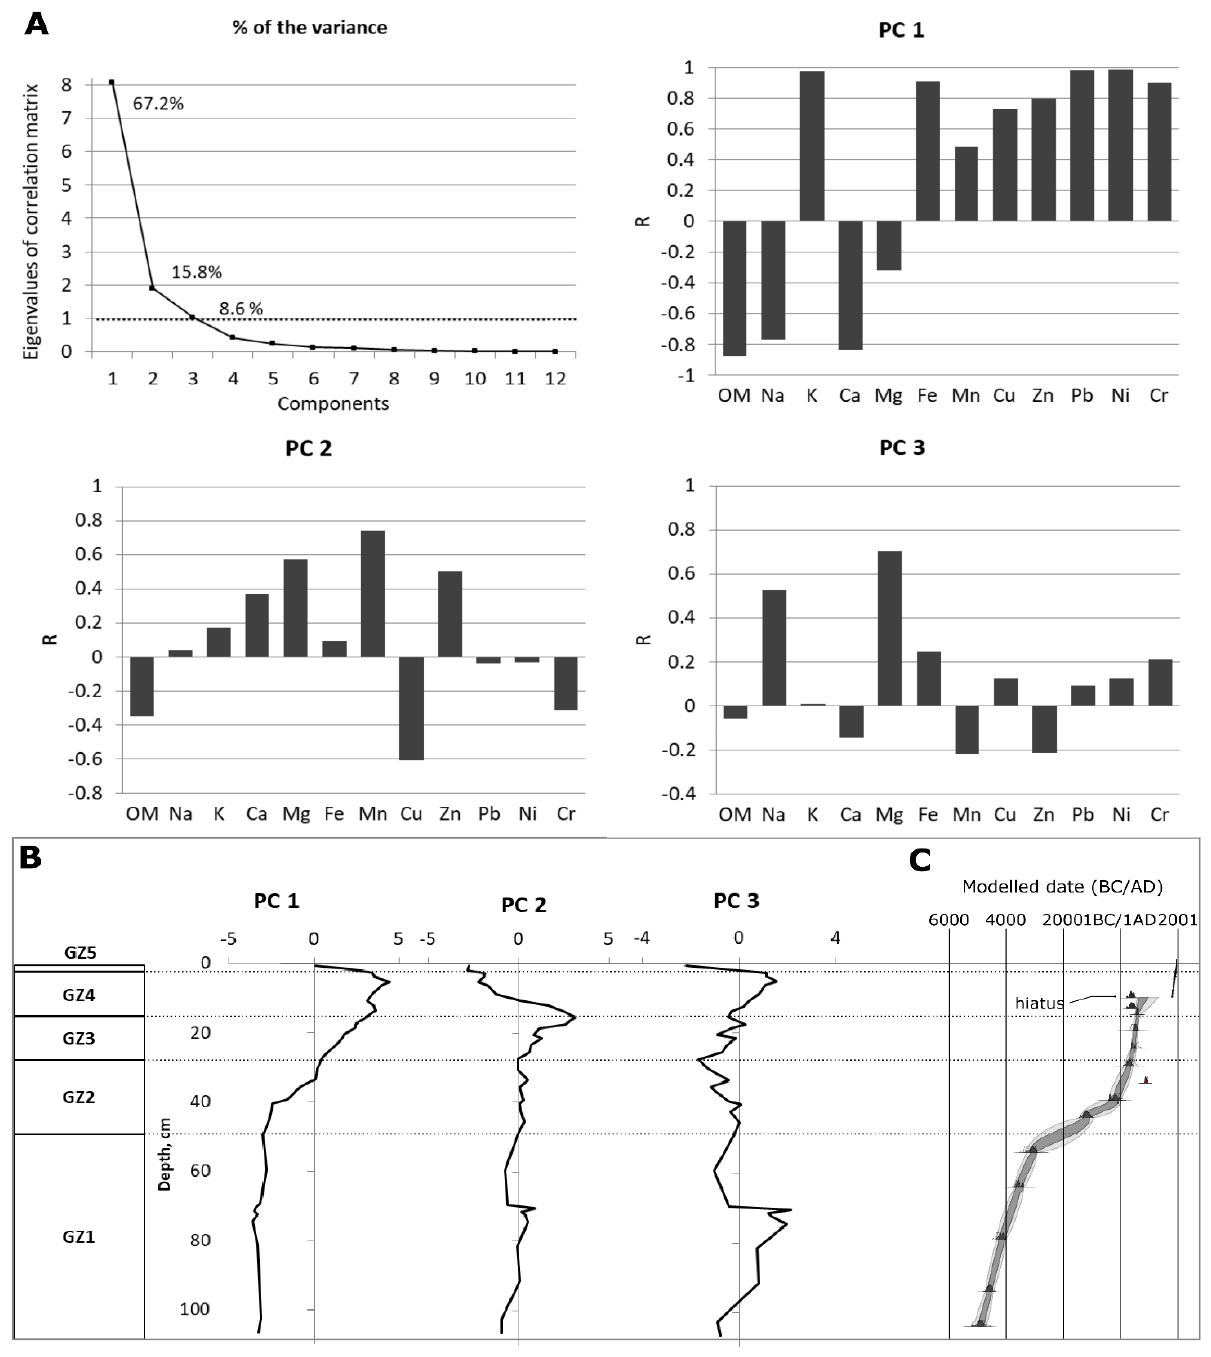
Figure 7. A: Eigenvalues of the correlation matrix (top left) and correlations of the geochemical variables determined by chemical analysis with the first three principal components (R = correlation coefficient); B: depth profiles of geochemical zones (GZ1–5) and the principal components PC1–PC3 in Core W3; and C: the age-depth model previously reported by Pawełczyk et al .